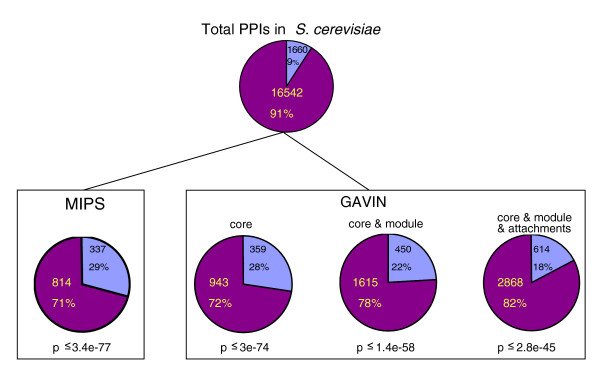
Interacting domain pairs are abundant in protein complexes. The frequency of DDIs in S. cerevisiae complexes is statistically significantly higher than their fraction in the whole interactome (P values were determined by χ2 test). The fraction of PPIs attributed to DDIs increases with the reliability of the interaction and is highest in the cores of the complexes. DDI, domain-domain interaction; PPI, protein-protein interaction.